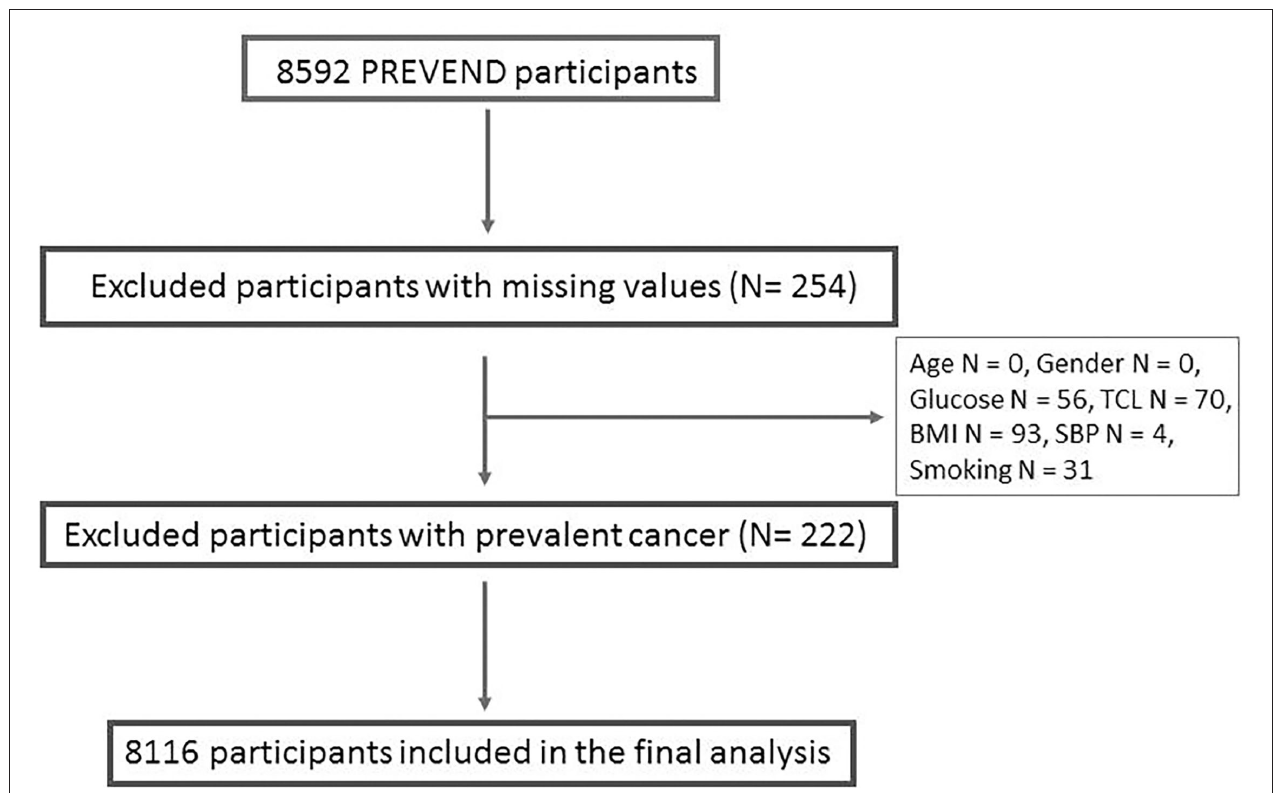
FIGURE 1 | Detailed description of the participants excluded from the analysis. TCL, total cholesterol; BMI, body mass index; SBP, systolic blood